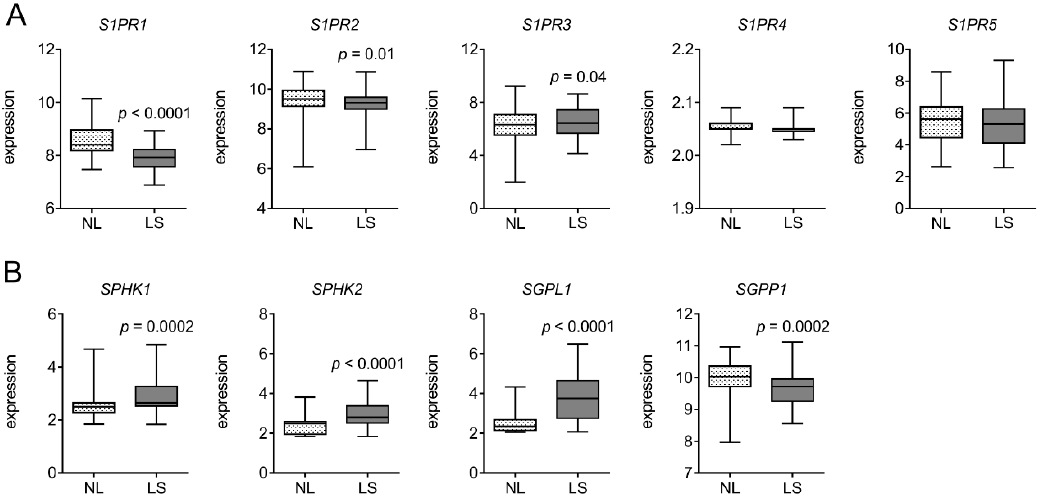
Figure 1. Sphingosine-1-phosphate receptor 1 ( S1PR1 ) is downregulated in human psoriatic patients. Gene expression data in Gene Expression Omnibus (GEO) dataset GSE30999 (21) were analyzed for ( A ) expression of S1P receptors and ( B ) S1P metabolizing enzymes in tissues from psoriatic patients with (LS) and without (NL) lesions ( n = 85). p values were calculated using two-tailed Student’s t -test.